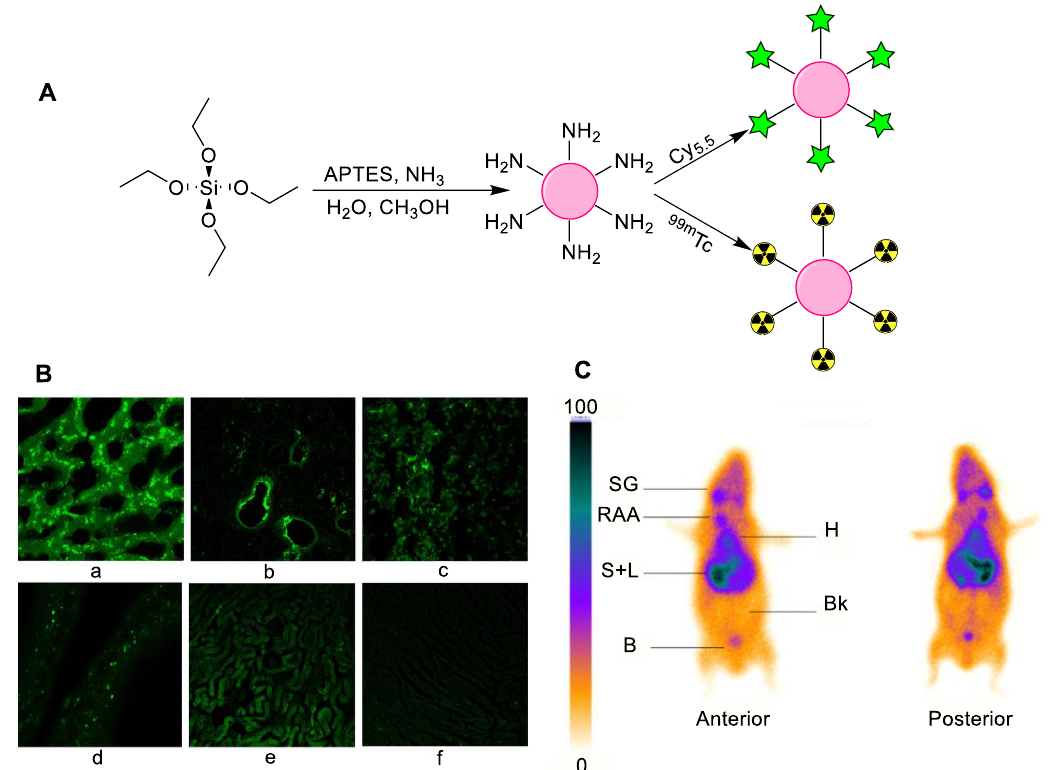
Figure 8. ( A ) Schematic diagram for the synthesis of Cy5.5 or 99m Tc conjugated silica nanoparticles; ( B ) biodistribution of Cy5.5-conjugated silica nanoparticles in ( a ) liver ( b ) lung ( c ) spleen ( d ) testis ( e ) kidney and ( f ) heart, 2 h post-oral administration; ( C ) scintigraphic images of 99m Tc radiolabeled silica NPs after oral administration (SG—salivary glands, RAA—radiotracer administration aria, H—heart, S—spleen, L—liver, B—bladder, Bk—background). Reprinted with permission from [49], with permission from Elsevier,